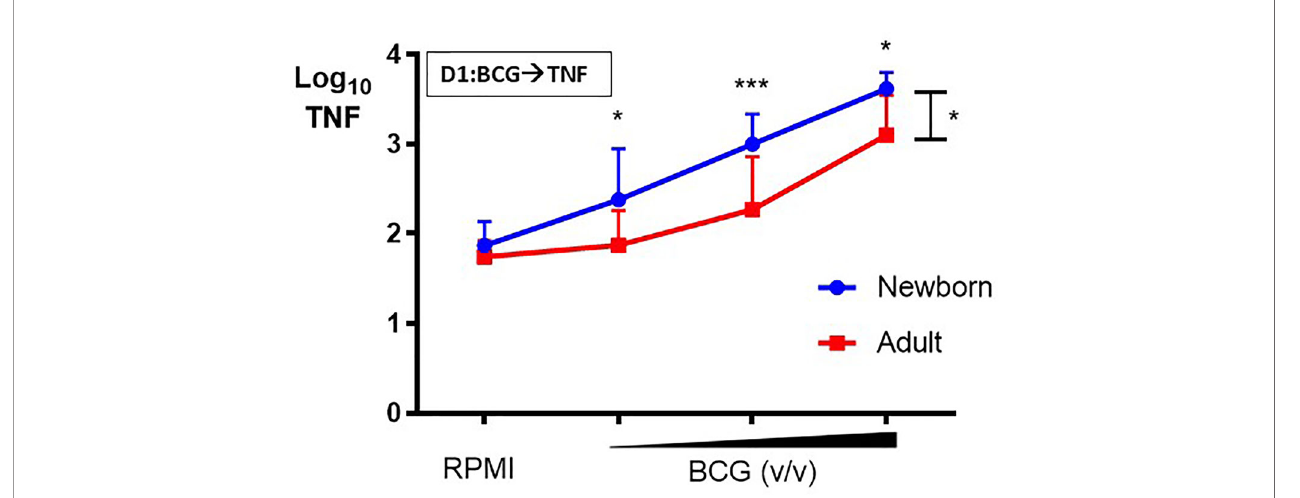
FIGURE 2 | Human newborn monocytes demonstrate distinct BCG-induced primary TNF responses. Human newborn and adult CD33+ monocytes were cultured in vitro as described in Figure 1 . In contrast to adult monocytes, neonatal monocytes demonstrated relatively greater primary TNF responses to BCG. Results are shown as log 10 cytokine concentrations due to skewed distribution of values. N = 7 newborns, 9 adults. D, Day; v/v, volumetric concentrations. Bars indicate mean + SD. Repeated-measures 1-way ANOVA was used for comparisons across BCG concentrations and 2-way ANOVA was used for comparisons between age groups. *p < 0.05; ***p < 0.001.